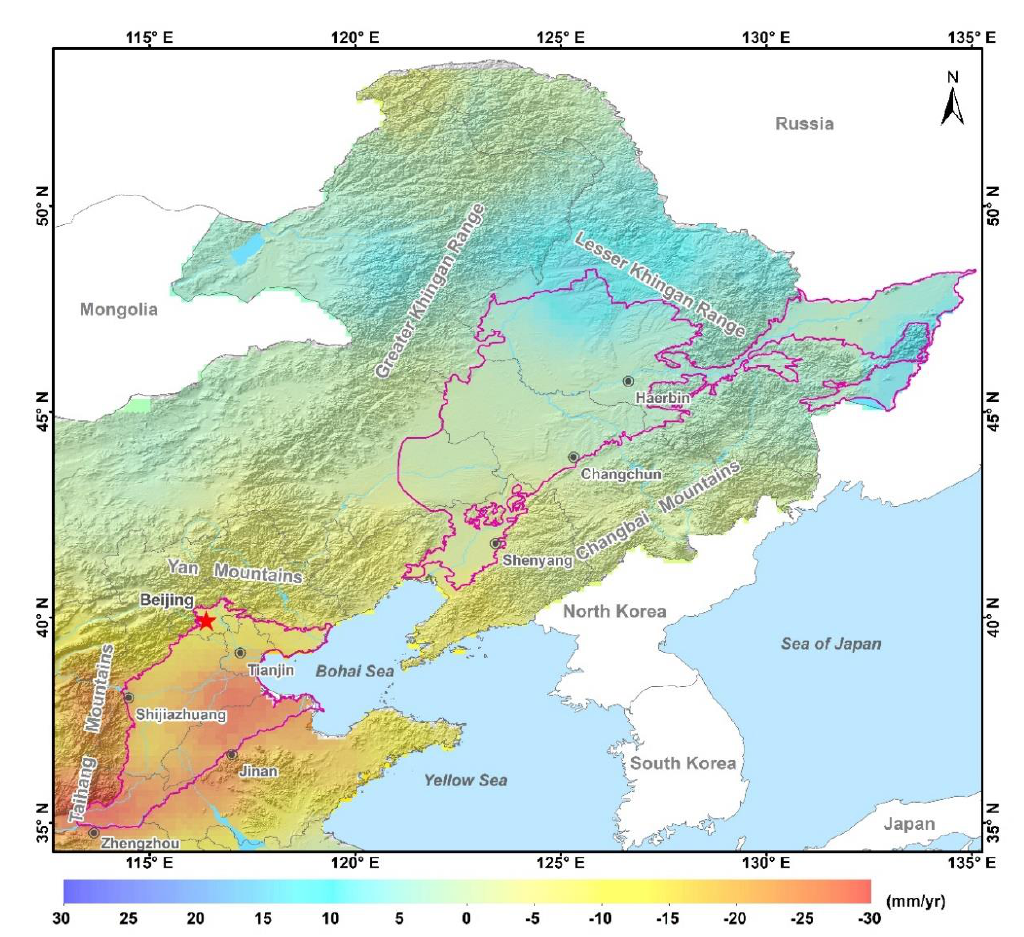
Figure 8. Spatial distribution of GWS trends based on GRACE data from 2003 to 2016.